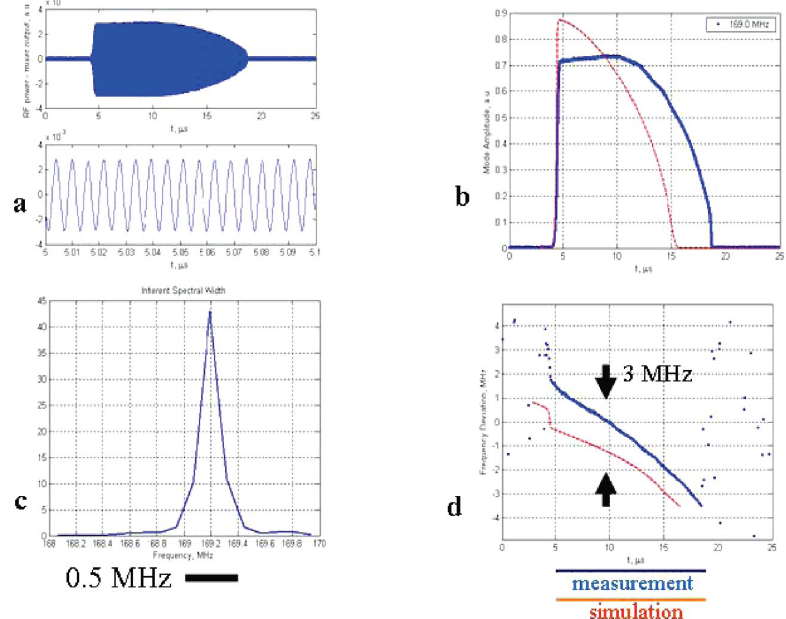
FIG. 2. (Color) Single-mode operation: (a) Original oscillogram. (b) Mode amplitude. The mode frequency is 84 401 MHz . In the I=Q analysis the low-pass filter is set to 15 MHz bandwidth. (c) Inherent spectral width after numerical elimination of the chirp (0.2 MHz). (d) Momentary frequency deviation obtained by a time derivative of the phase deviation. Data measured (continuous line) and simulated (dotted line). The chirp rate is approximately 0 : 35 MHz =(cid:1) s in both